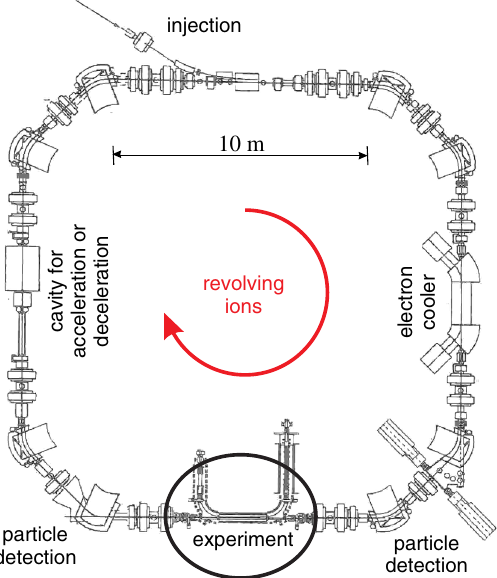
FIG. 2 (color online). Schematic drawing of the test storage ring (TSR) [14]. The injection, electron cooler, acceleration cavity, and particle detector setups are indicated. A core of a reactor can be imagined at place for in-ring experiments (adopted from Ref.